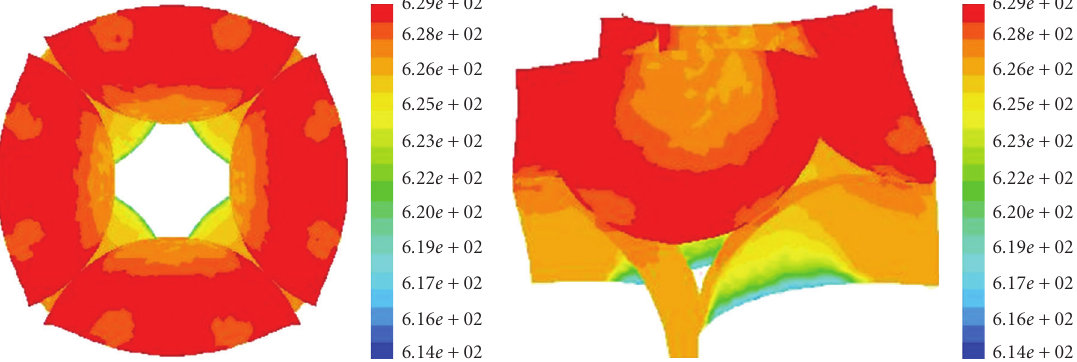
Figure 7: Two views of the wall temperature distribution (in Kelvin degrees) for FCC cell “new1” (Steady State—Average Channel).